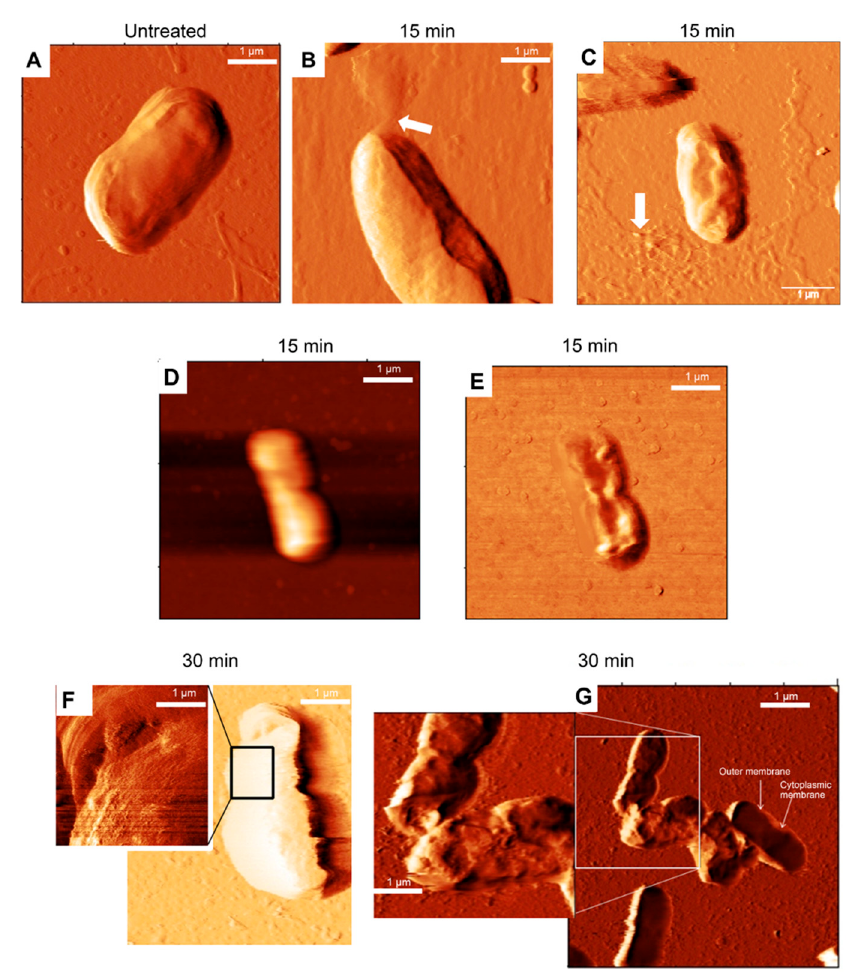
Figure 5. Effect of the C 14 -KYR on the bacterial morphology. AFM deflection images of E. coli cells incubated in the absence ( A ) and the presence of C 14 -KYR for 15 ( B – E ) and 30 min ( F , G ). After being treated with C 14 -KYR for 15 min ( B , C ), the intracellular fluid leaked out of the cell. The topography ( D ) and phase ( E ) images of the E. coli HB101 cell after 15 min of incubation with C 14 -KYR. The structure of the outer membrane of the C 14 -KYR-treated cell was maintained, but a change in the inner membrane due to cell shrinkage was observed in the phase image. The cell membrane became damaged and separated from the cell wall after 30 min of treatment ( F , G ). AFM images in 5 µm × 5 µm and 2.5 µm × 2.5 µm were performed using a silicon nitride cantilevers with a spring constant of ~0.13–0.16 N/m, a resonant frequency of 5 kHz, and a scanning speed 0.5–0.6 Hz.